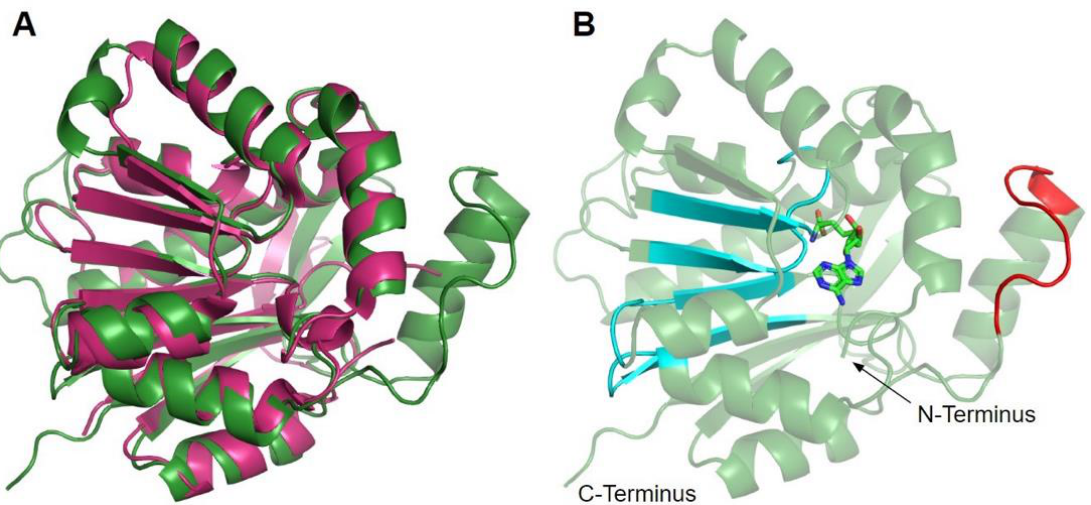
Figure 5. Alignment of AlphaFold-generated model of human COQ3 with existing E. coli UbiG crystal structure. ( A ) Superimposition of the human COQ3 model (residues 91–336, shown in dark green), adapted with permission from [39,54], and the crystal structure of AdoHcy-bound E. coli UbiG (shown in magenta, PDB: 5DPM). The N- and C-termini of the model were omitted due to low confidence. Note that this and subsequent figures about COQ3 were generated using PyMOL, which classifies a short-coil region as a helix (top left of figure). This gives a total of nine helices as opposed to eight rendered in Figure 4. ( B ) Human COQ3 model with conserved methyltransferase motifs I – III and post-I highlighted in cyan and the hydrophobic region in red. AdoMet (shown in light green) was modeled via structural alignment with PDB 5DPM using PyMOL.